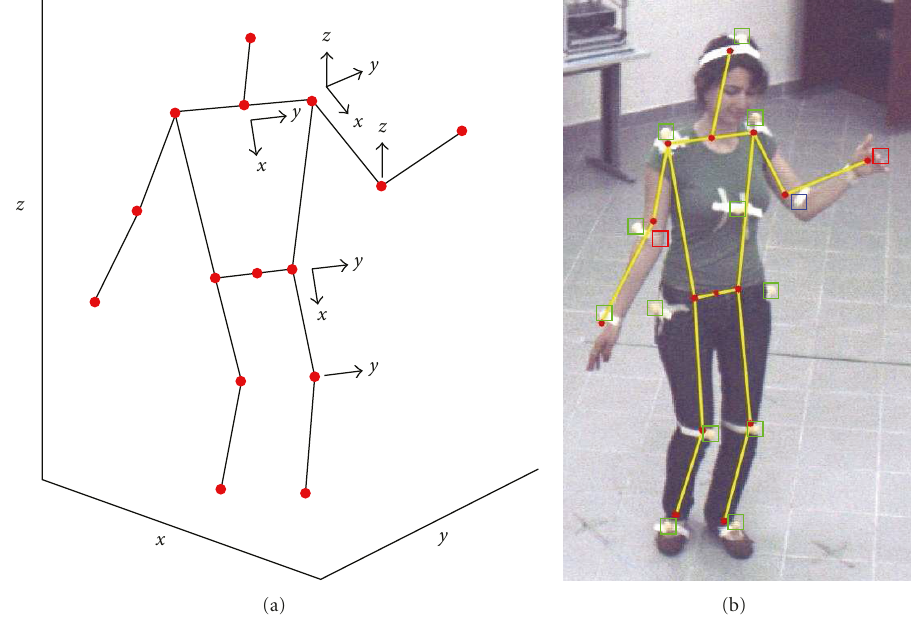
Figure 2: Human body model and measurement examples. In (a), the HBM employed in this paper is parameterized as follows: 2DOF in the neck, 3 DOF in the shoulders, 1 DOF in the elbows, 3DOF in the hips, 3 in the lower torso and 1 DOF in the knee. Red dots mark the HBM landmarks that can be computed by applying forward kinematics. In (b), the output of the employed color based marker location detection algorithm. Colors describe the correct detections (green), the miss detections (blue) and the false positive detections (red). All this detections will conform the measurement set D n .